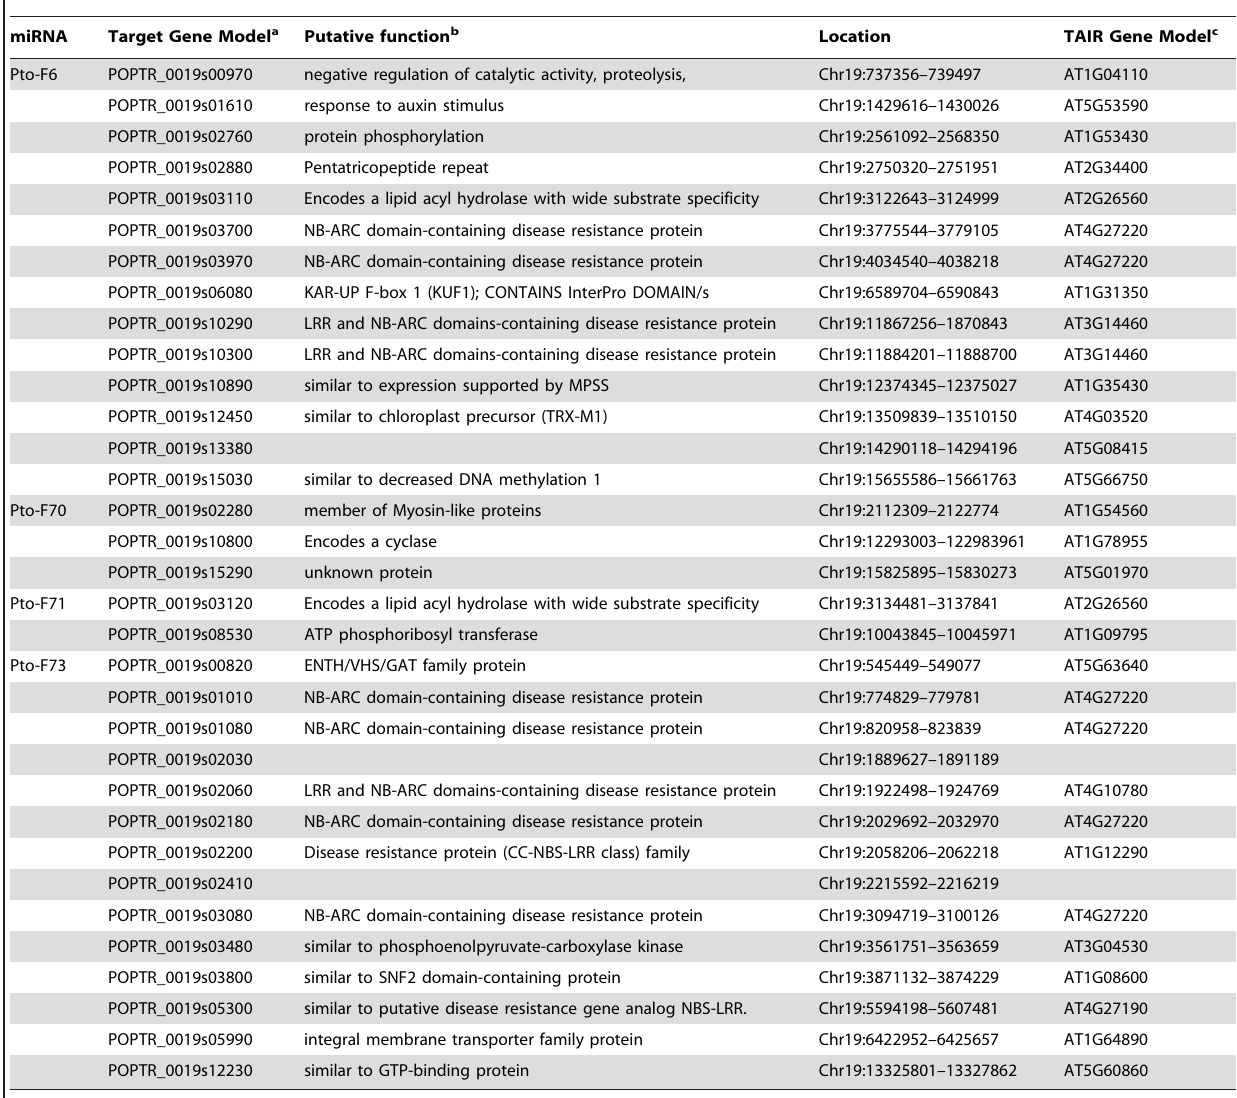
Table 6. Targets of novel P. tomentosa miRNAs verified in XIX chromosome of poplar.